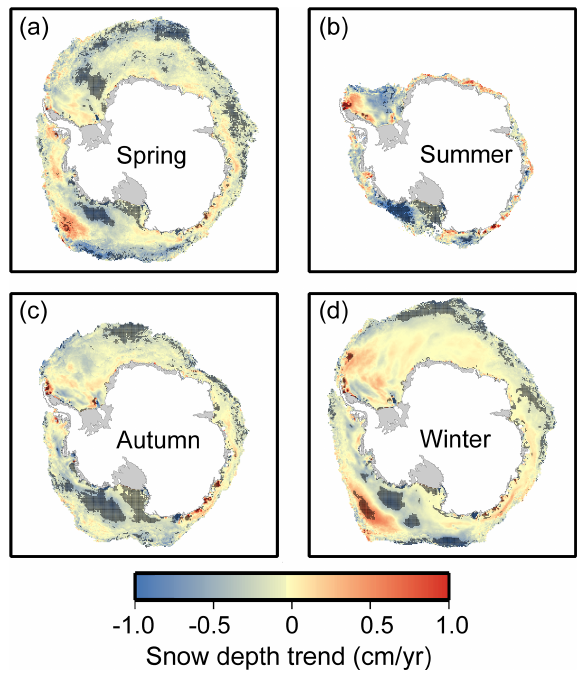
Figure 11. The spatial distributions of snow depth trends in differ- ent seasons from 2002 to 2020. For each grid cell, the trend was only estimated when 12 years (or more) of snow depth estimates were obtained. Only grid cells with sea ice concentration ≥ 75% are shown here; grid resolution is 25km. The black dot means that the trend is significant at the 95% significance level according to two-tailed Student’s t